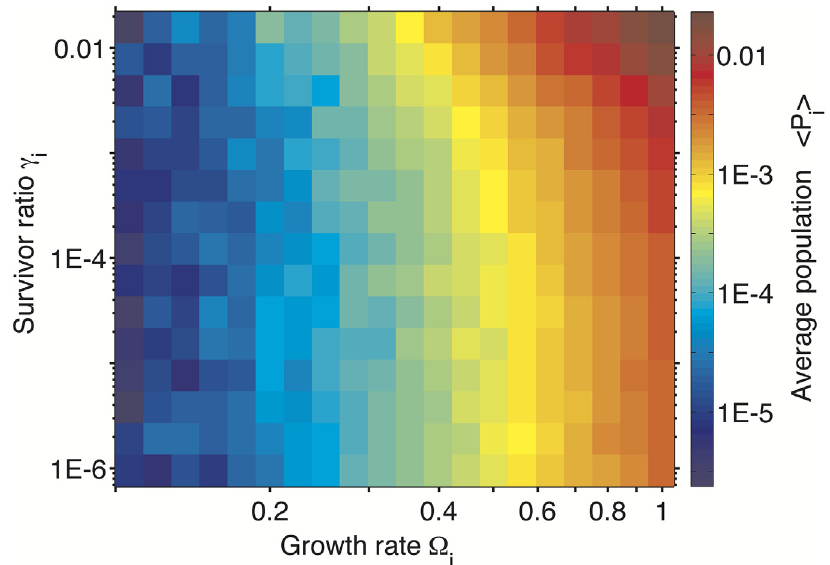
Fig 6. Average population vs species ’ properties in the “ Resilience model ” variant #7. Time-averaged population of a species (see color scale on the right) plotted as a function of its re-population growth rate Ω i (x-axis) and population drop after collapses γ i (y-axis). in a variant of our model with fitness differences between species. Note that the population increase with both Ω i and γ i . Populations and fitness parameters of N = 1000 species were taken from 50 million snapshots of the